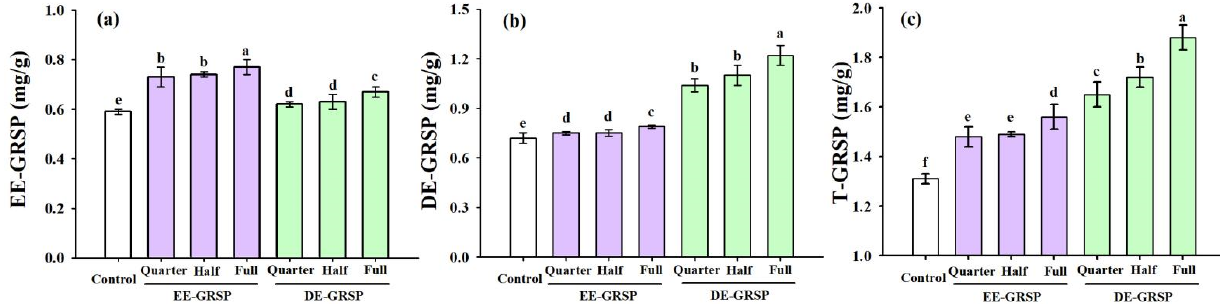
Figure 8. Effects of exogenous EE-GRSP and DE-GRSP on endogenous EE-GRSP ( a ), DE-GRSP ( b ), and T-GRSP ( c ) content in the rhizosphere of trifoliate orange seedlings. Data (mean ± SD, n = 4) followed by different letters above the bars indicate significant differences ( p < 0.05) between treatments.